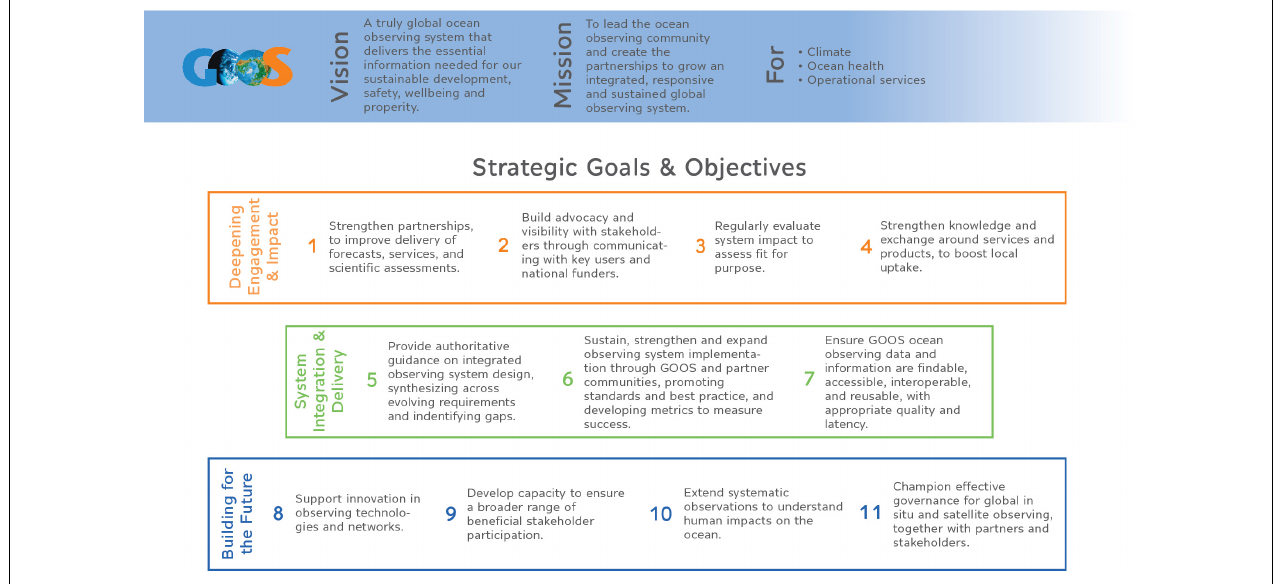
FIGURE 6 | GOOS 2030 Strategy; vision and mission statements with strategic goals and correlating